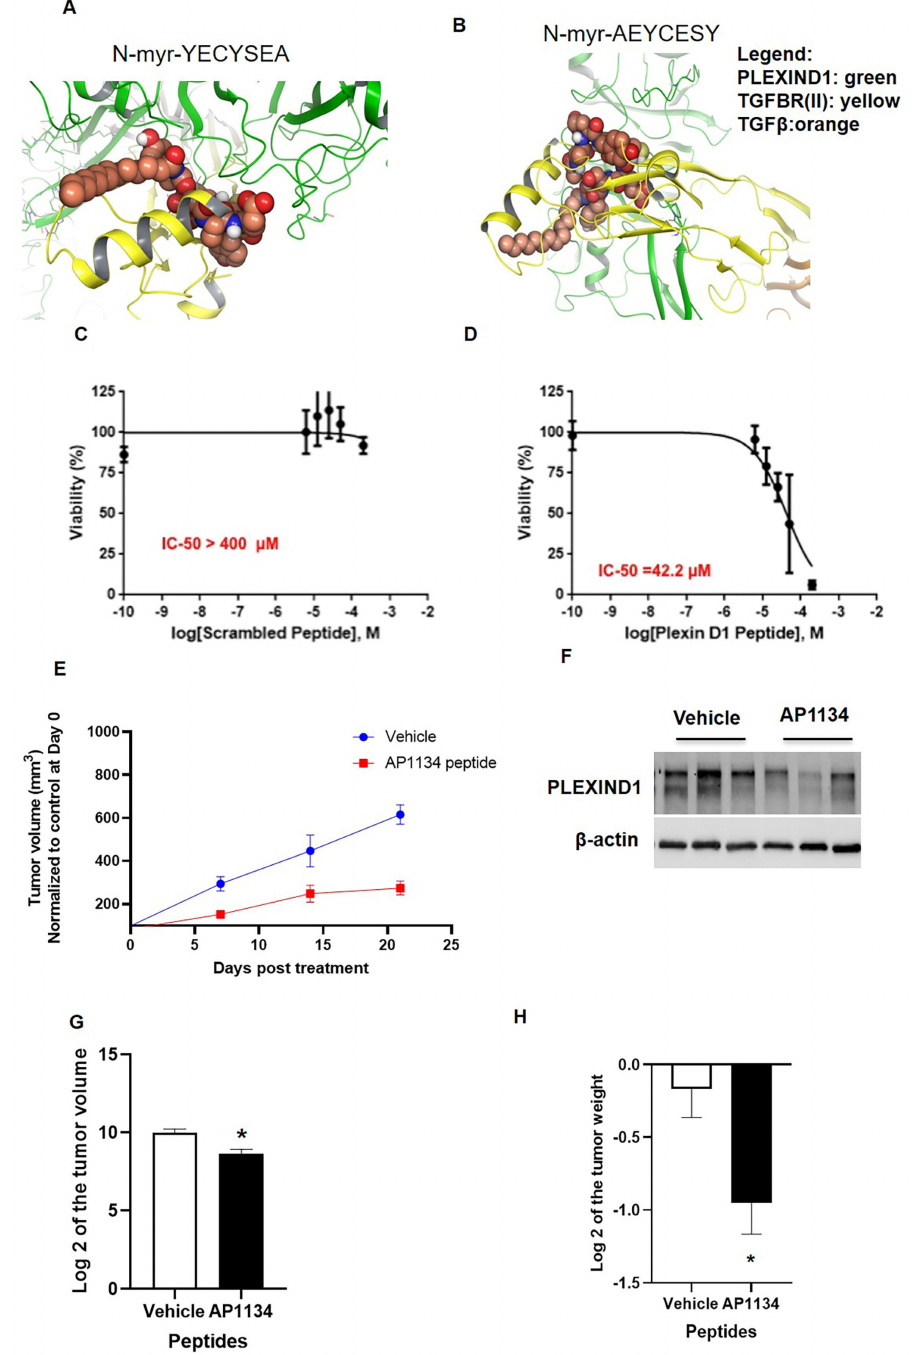
Figure 7. Therapeutic potential of peptide-mediated targeting of PLEXIND1. ( A , B ): Computational modeling showing YECYSEA and AEYCESY sequences interacting with PLEXIND1- TFGBRII-TGF β complex. The peptide is shown in orange carbon “sticks”, and the nearby PLEXIND1 residues are shown in gray carbons (but residues of type Ala or Asp are shown in purple carbon). ( C , D ): Cell viability assays for PANC-1 cells treated with either scramble or PLEXIND1 targeting peptide. ( E ): Tumor volume from NSG mice models in which first tumors were grown until about 250 mm3 and then were treated with either vehicle (control) or AP1134. ( F ): Western blot analysis confirming the reduced expression of PLEXIND1 upon AP1134 peptide treatment. ( G , H ): Log 2 values of tumor volumes and weights from NSG mice treated with either vehicle (control) or AP1134 at the termination of the experiment. * p < 0.05 vs. control. Error bars represent standard error of the